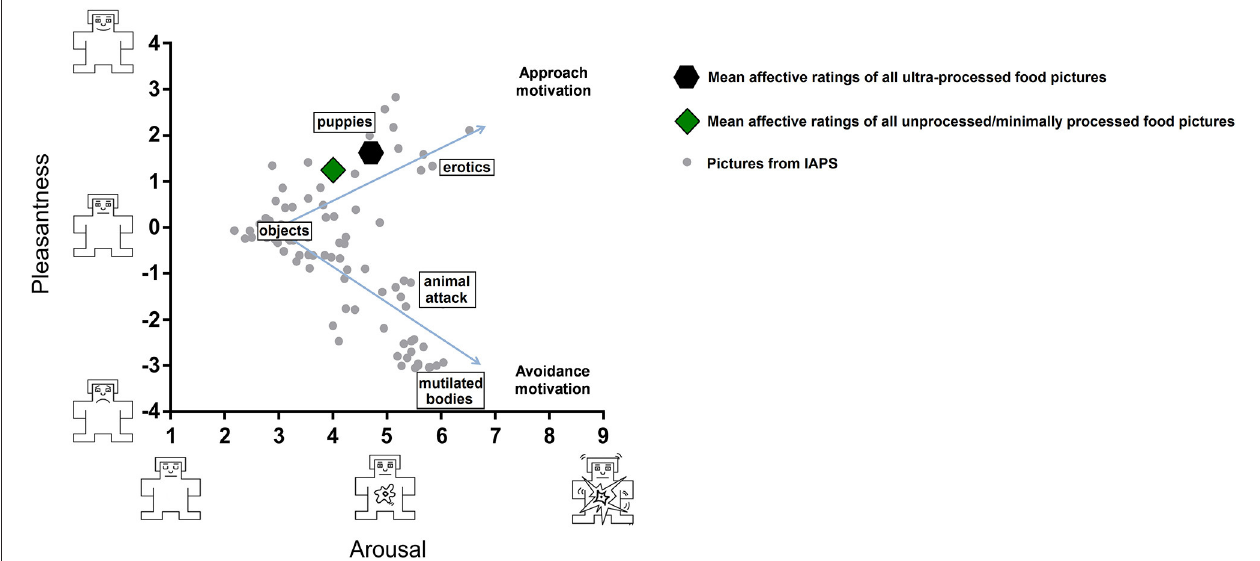
FIGURE 2 | Affective space. Illustration of the bidimensional affective space defined by each picture’s mean pleasure (y-axis) and arousal (x-axis) ratings with presentation of the motivational tendencies of approach (top half of plot) and avoidance (bottom half of plot) elicited by each picture. Each gray dot ( ) in the plot represents IAPS pictures used as background (e.g., nature, family, sports, adventure, erotic pictures, puppies, people, landscape, objects, pollution, illness, loss, accidents, contamination, attacking animals, attacking humans, and mutilated bodies). The mean affective ratings of all UPF pictures are represented by the hexagon symbol ( ) and mean of all UMPF pictures by the diamond symbol ( ). IAPS, International Affective Picture System; UMPF, unprocessed/minimally processed foods; UPF, ultra-processed foods.